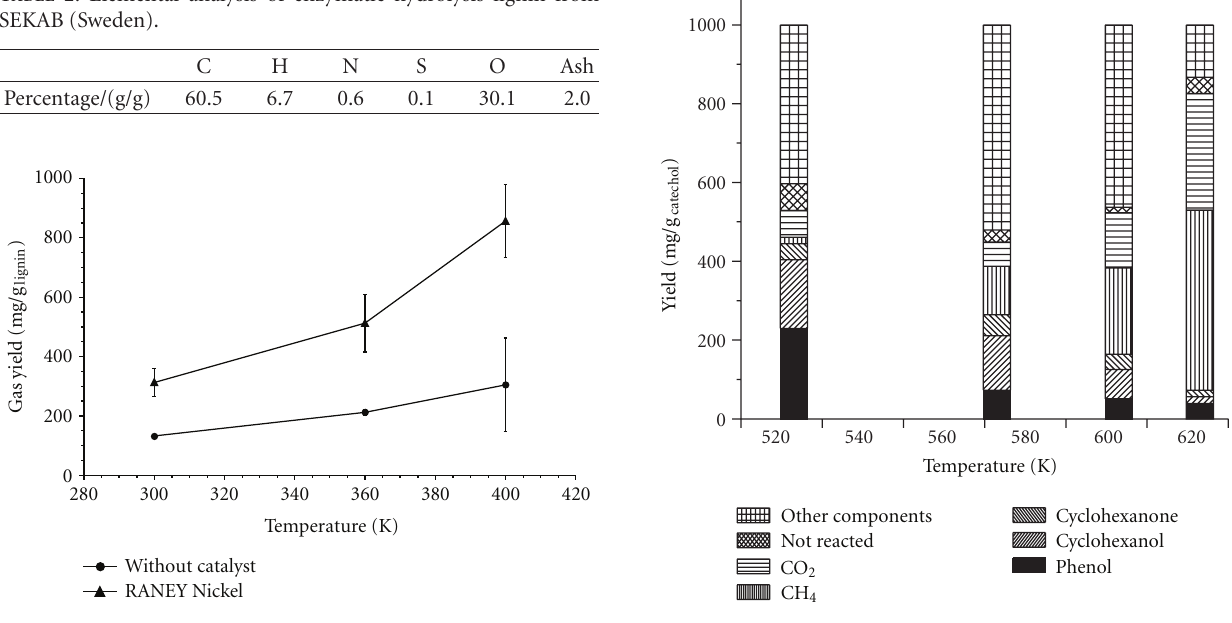
Figure 4: Gas yield with and without catalyst at di ff erent tempera- tures and 30min reaction time.